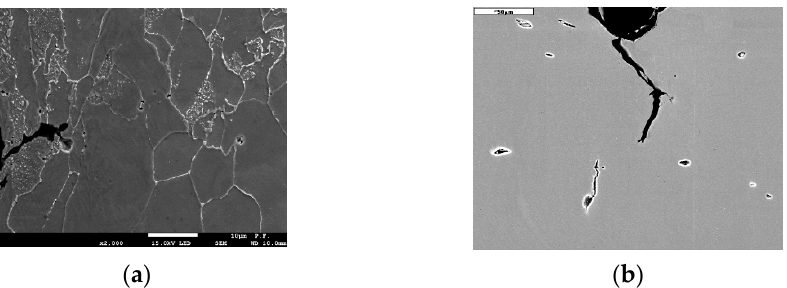
Figure 16. Deformed and damaged material in front of crack tip in SENB specimen: ( a ) S355 steel; ( b ) 14MoV6 steel.